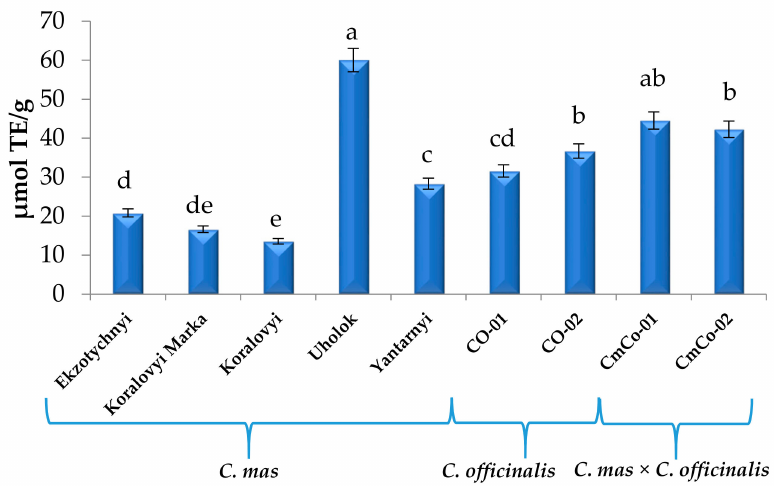
Figure 5. Antioxidant capacity of Cornus mas L., C. officinalis Siebold & Zucc., and C. mas × C. officinalis fruit extracts evaluated by ABTS method, µ mol TE/g (means in columns followed by different letters are statistically different at p ≤ 0.05). ABTS, 2,2 (cid:48) -azino-bis (3-ethyl benzothiazoline-6-sulfonic